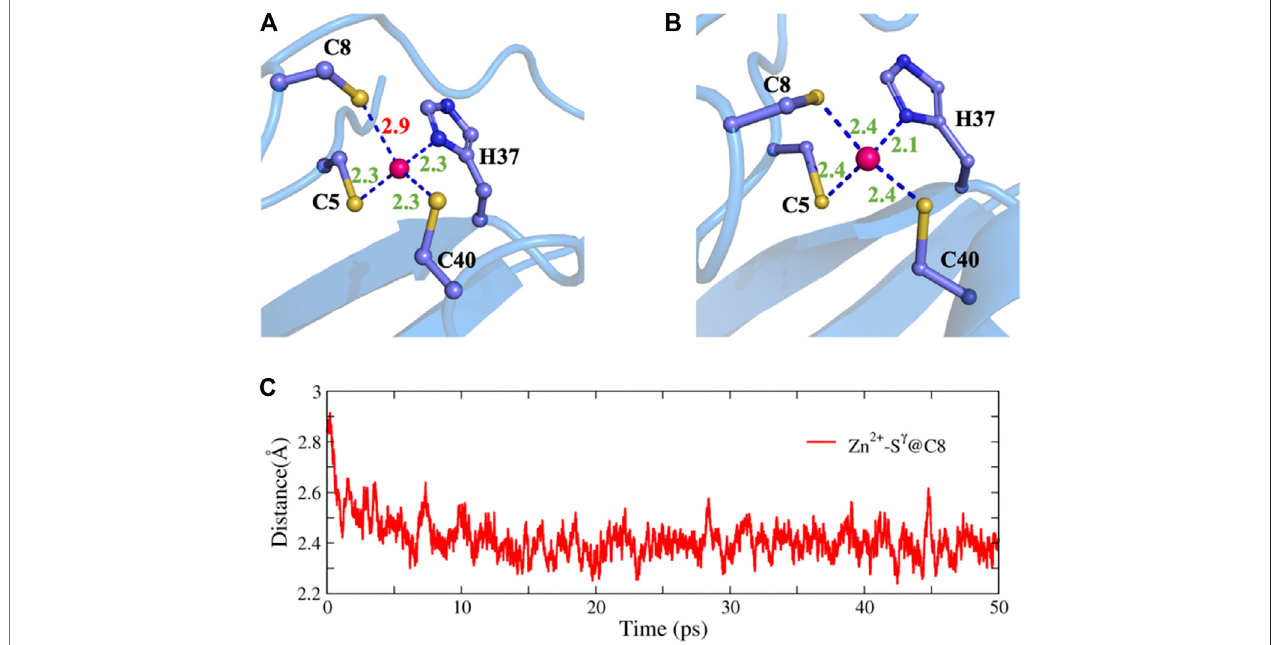
FIGURE6| Structure re fi nement with NN potential for anill structure ofthe 2L30protein. (A) Theill structure, (B) there fi ned structure,and (C) thetime evolutionof the Zn-S distance.